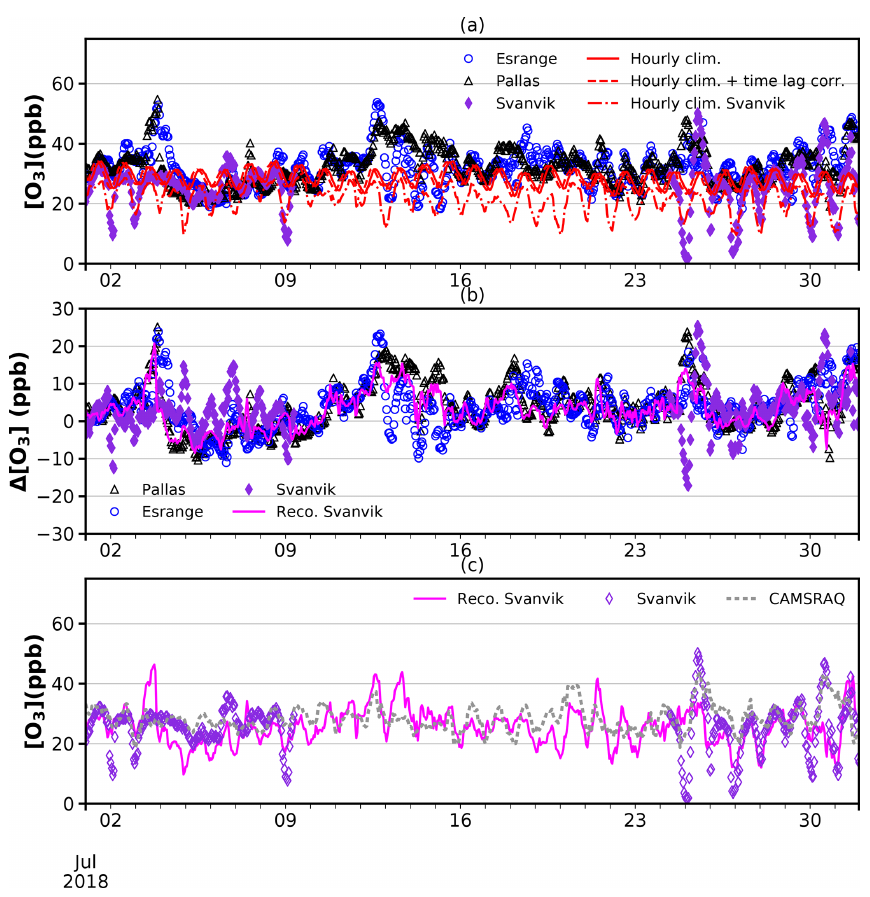
Figure 6. Reconstruction procedure for missing [ O 3 ] data (9–23 July 2018). Observed 1-hourly [ O 3 ] values are shown together with 1- hourly climatologies derived for northern Fennoscandia (combined data from Esrange, Jergul/Karasjok, Pallas) and Svanvik. (a) Time series supplemented with 1-hourly climatologies. The time-lag correction of the northern Fennoscandia climatology is also indicated; (b) observed and reconstructed anomalies; (c) reconstructed [ O 3 ] for Svanvik in comparison with CAMSRAQ evaluated at the nearest-neighbor grid